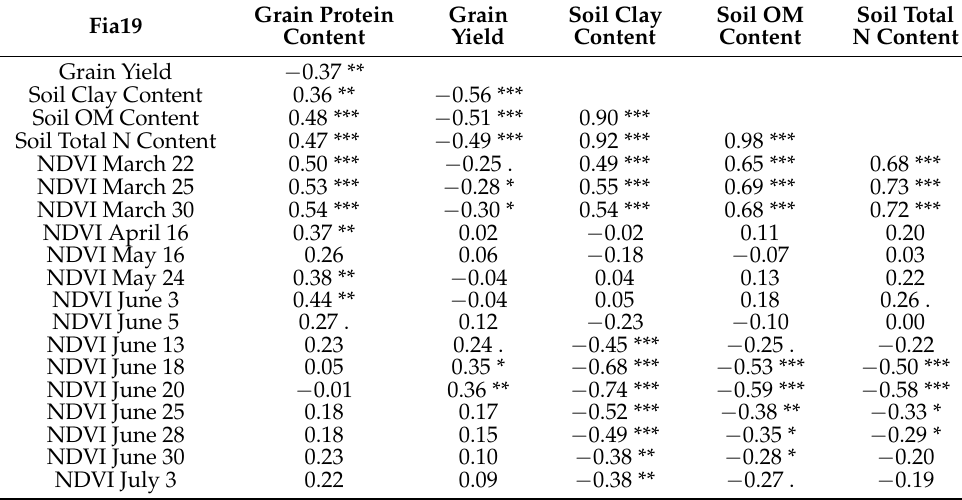
Table 8. Pearson correlation analysis and significance levels (. = 0.10; * = 0.05; ** = 0.01; *** = 0.001) between NDVI, grain yield, protein content, and soil parameters for the Fia19 field.